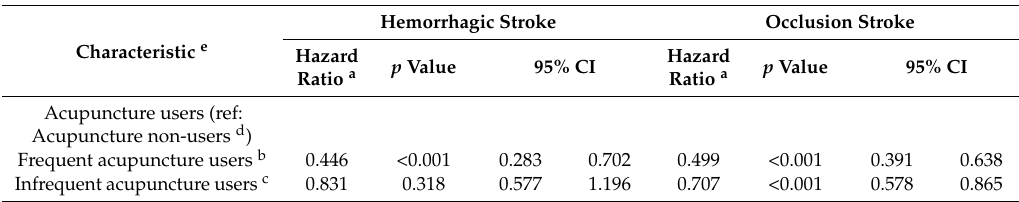
Table 3. Multivariable adjusted hazard ratios of covariates for depression between hemorrhagic stroke and occlusion